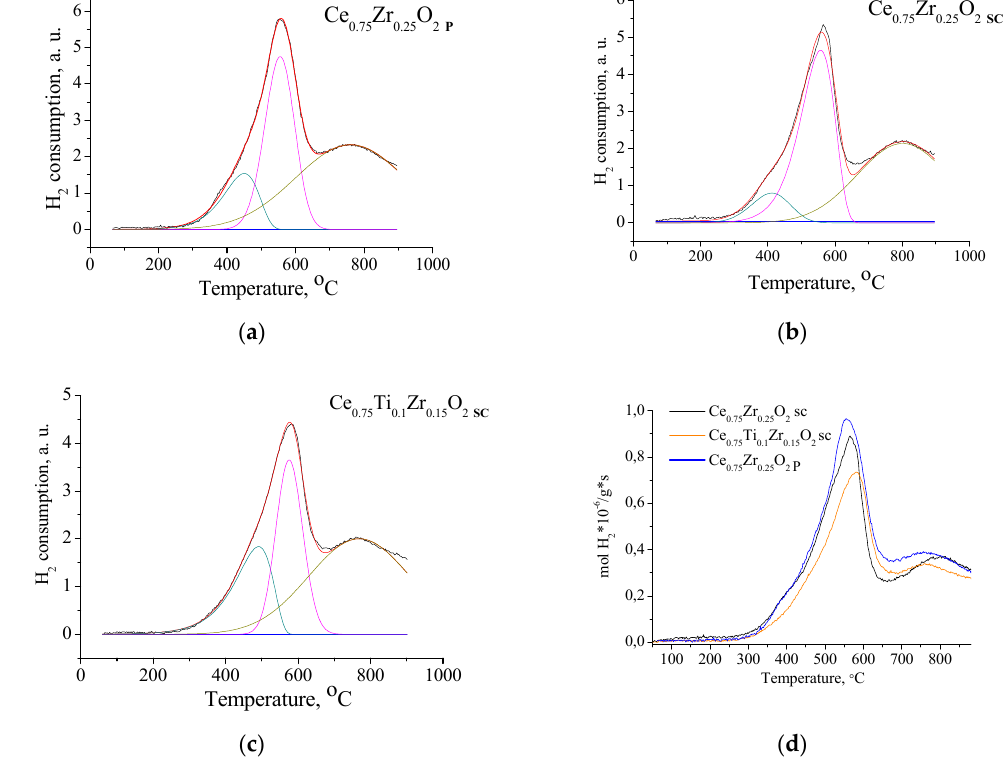
Figure 7. TPR-H 2 spectra of Ce 0.75 Zr 0.75 O 2- δ prepared by Pechini route (a) and in SC conditions ( b ), Ce 0.75 Ti 0.1 Zr 0.15 O 2- δ , prepared in supercritical alcohols ( c ); comparison of TPR-H 2 profiles of supports ( d ).